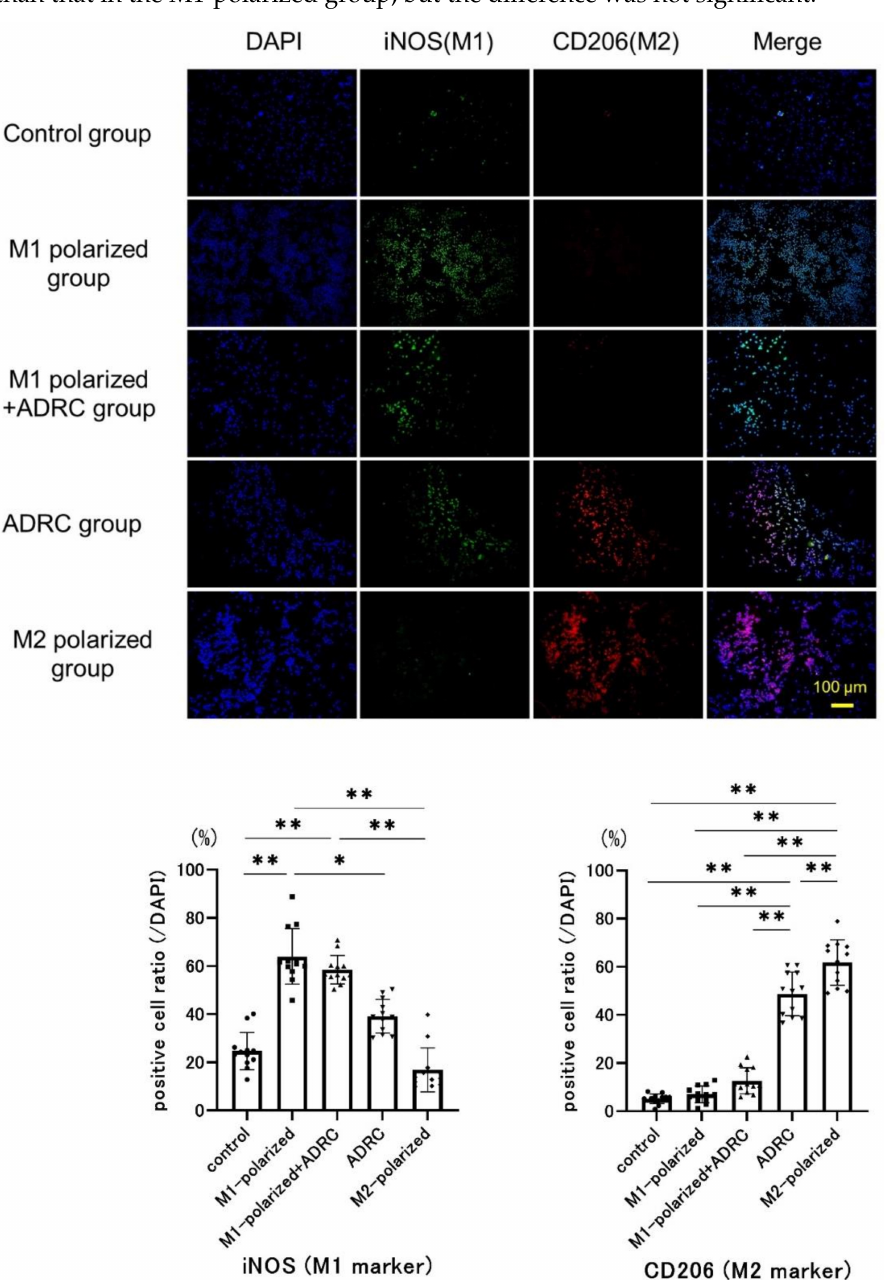
Figure 6. Immunocyto-fluorescent analysis of the effect on the macrophages by co-culture assay with ADRCs. Representative images showed immunofluorescent staining for the macrophage marker iNOS (green) and CD206 (red). Scale bars = 100 µ m. Graphs show the ratio of the number of positive cells to the number of DAPI-positive cells for iNOS and CD206. * p < 0.05, ** p <